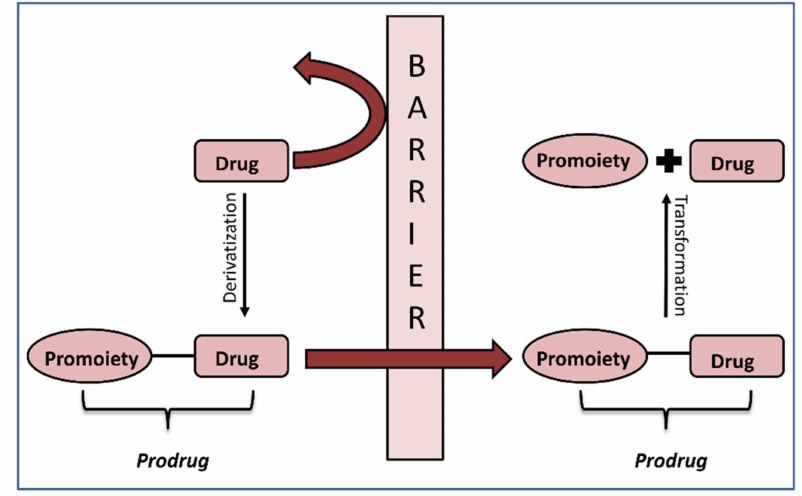
Figure 1. Illustration of the prodrug approach